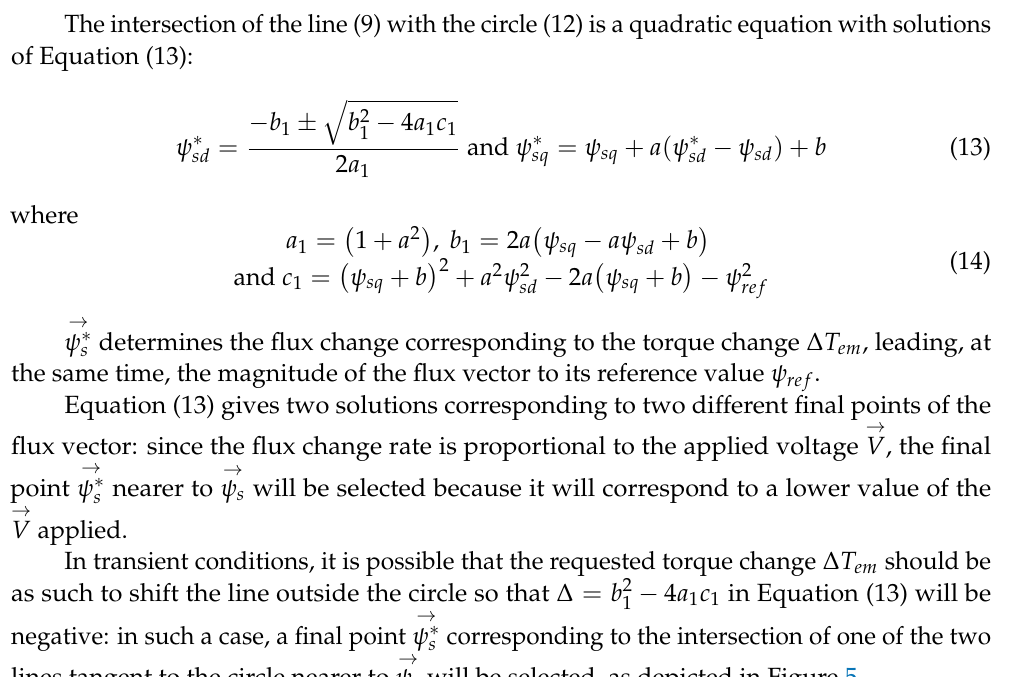
Figure 4. The locus of the final points of the flux vector 𝜓 (cid:3046) ∗ (cid:4652)(cid:4652)(cid:4652)(cid:4652)⃗ corresponding to the torque change ∆𝑇 (cid:3032)(cid:3040) .